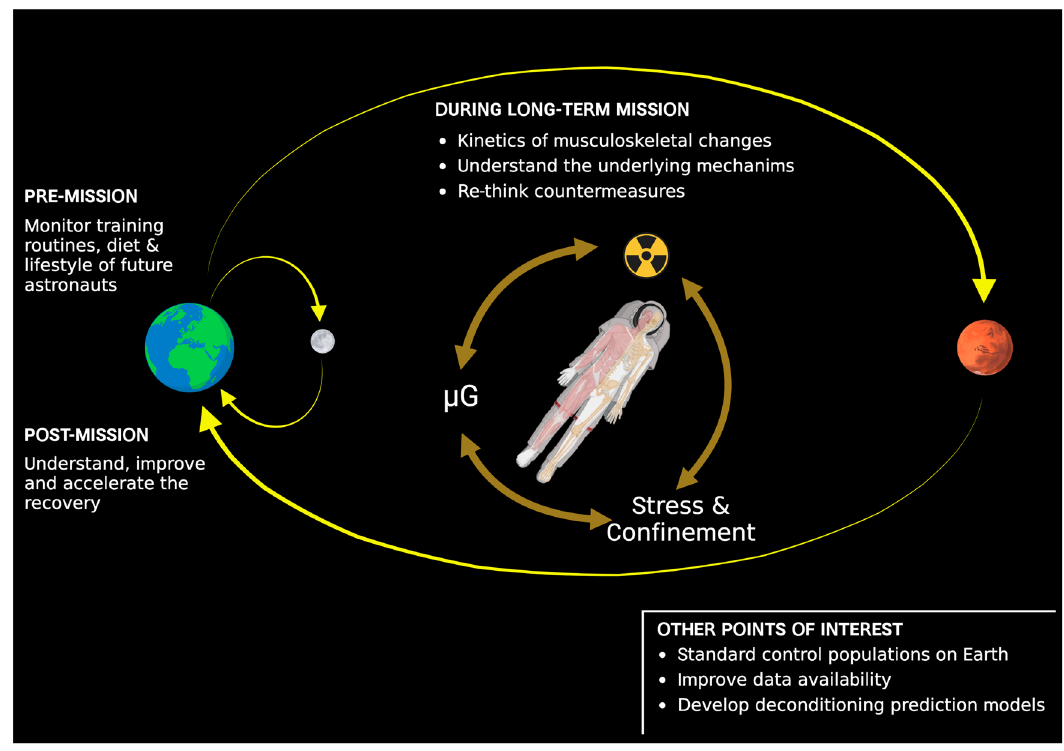
Fig. 1 Crewed deep space exploration. Unmet needs and points of interest to maintain musculoskeletal health and performance during upcoming human long-term space